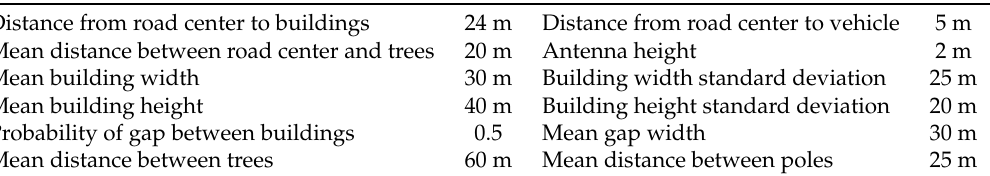
Table 2. Some urban scenario parameters.